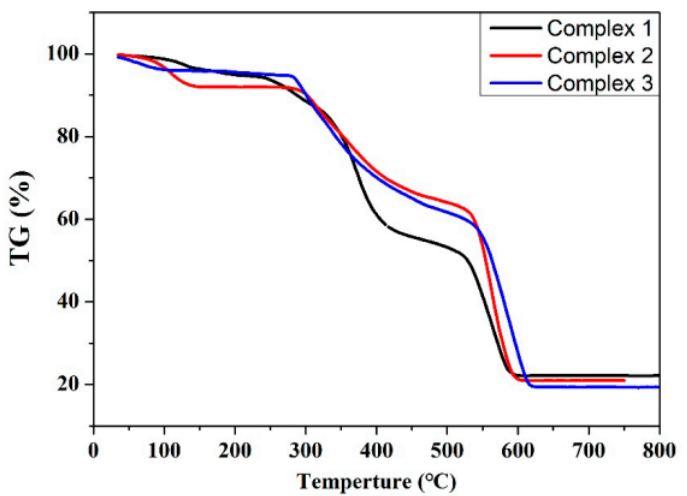
Figure 5. TG plots of complexes 1 – 3